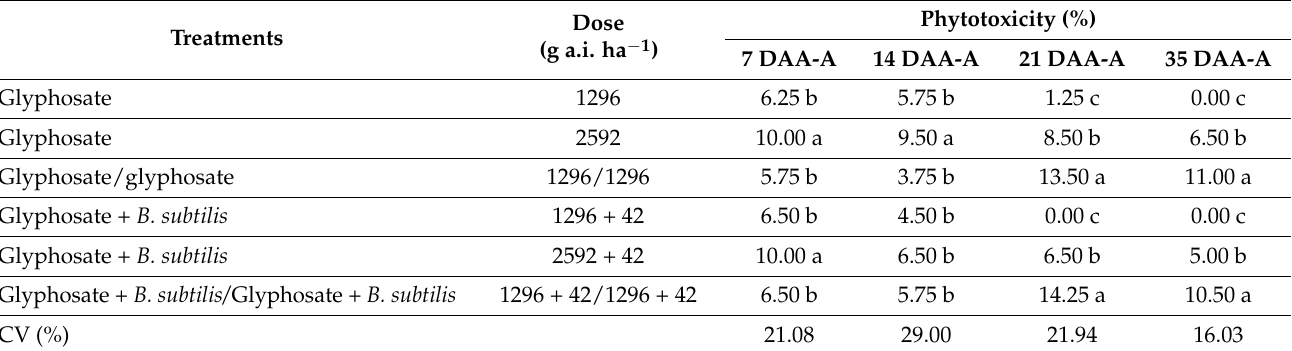
Table 2. Soybean phytotoxicity after post-emergence application of glyphosate at different doses and stages and association with B. subtilis BV02.